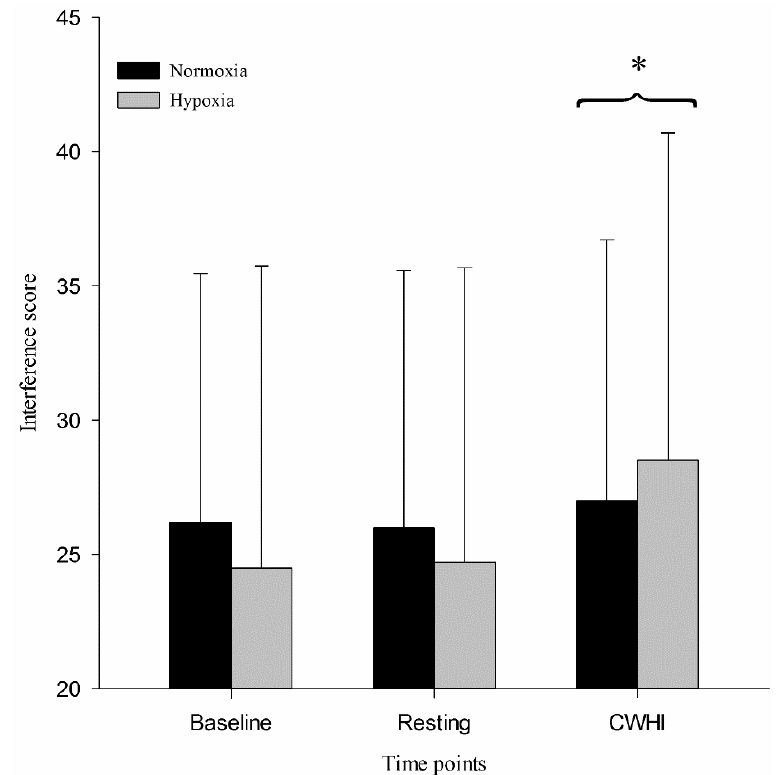
Figure 1. Interference score of the Stroop Color Word Test during baseline, resting, and CWHI. * p < 0.05, significantly different compared to “Resting”.